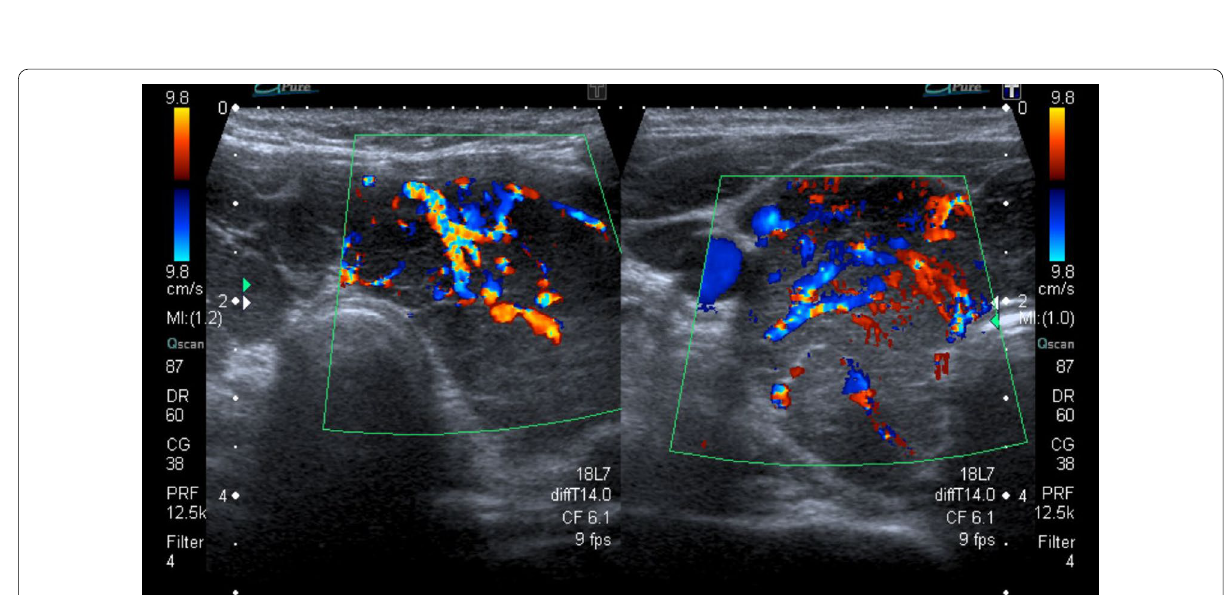
Fig. 4 Female hypothyroid patient, 27-years old. thyroid gland transverse view Doppler U/S shows parenchymal echogenicity grade 2 with evident increased gland